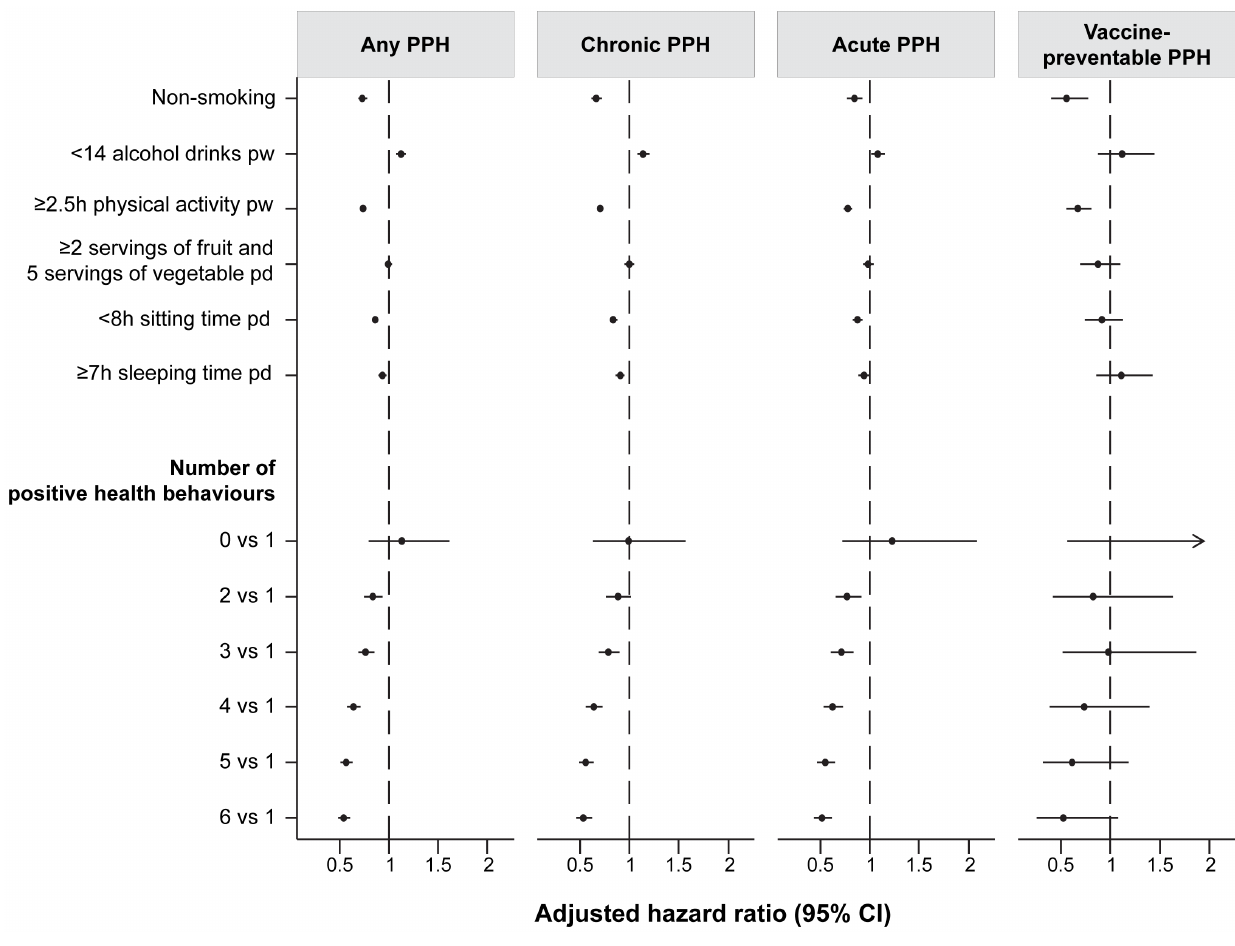
Figure 1. Risk of chronic, acute, and vaccine-preventable hospitalisations according to individual and combine of health behaviours. Hazard ratios (95% CI) estimated for the effect of each positive health behaviour on risk of PPH admission were adjusted for age, sex, education, marital status, income, remoteness, language other than English, private health insurance, history of chronic diseases, prior PPH admission and mutually adjusted for other health behaviours. Hazards ratios (95% CI) estimated for the effect of number of positive health behaviours on risk of PPH admission were adjusted for age, sex, education, marital status, income, remoteness, language other than English, private health insurance, history of chronic diseases and prior PPH admission.